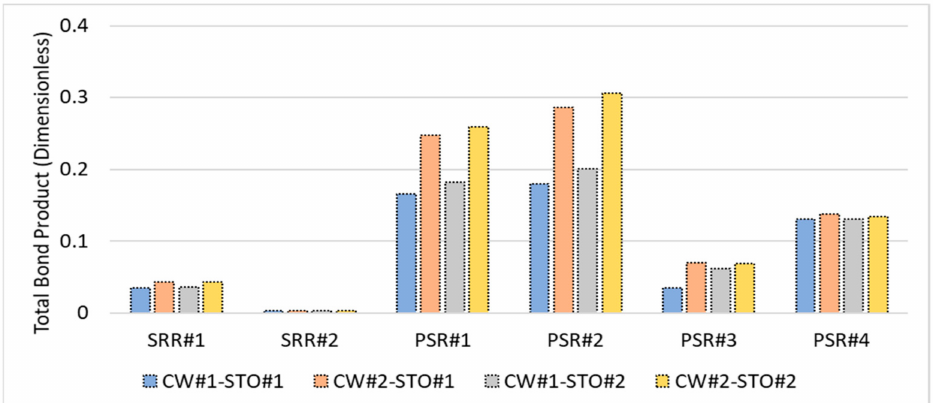
Figure 7. Total bond product (oil adhesion tendency) of reservoir rocks and mineral mixtures during